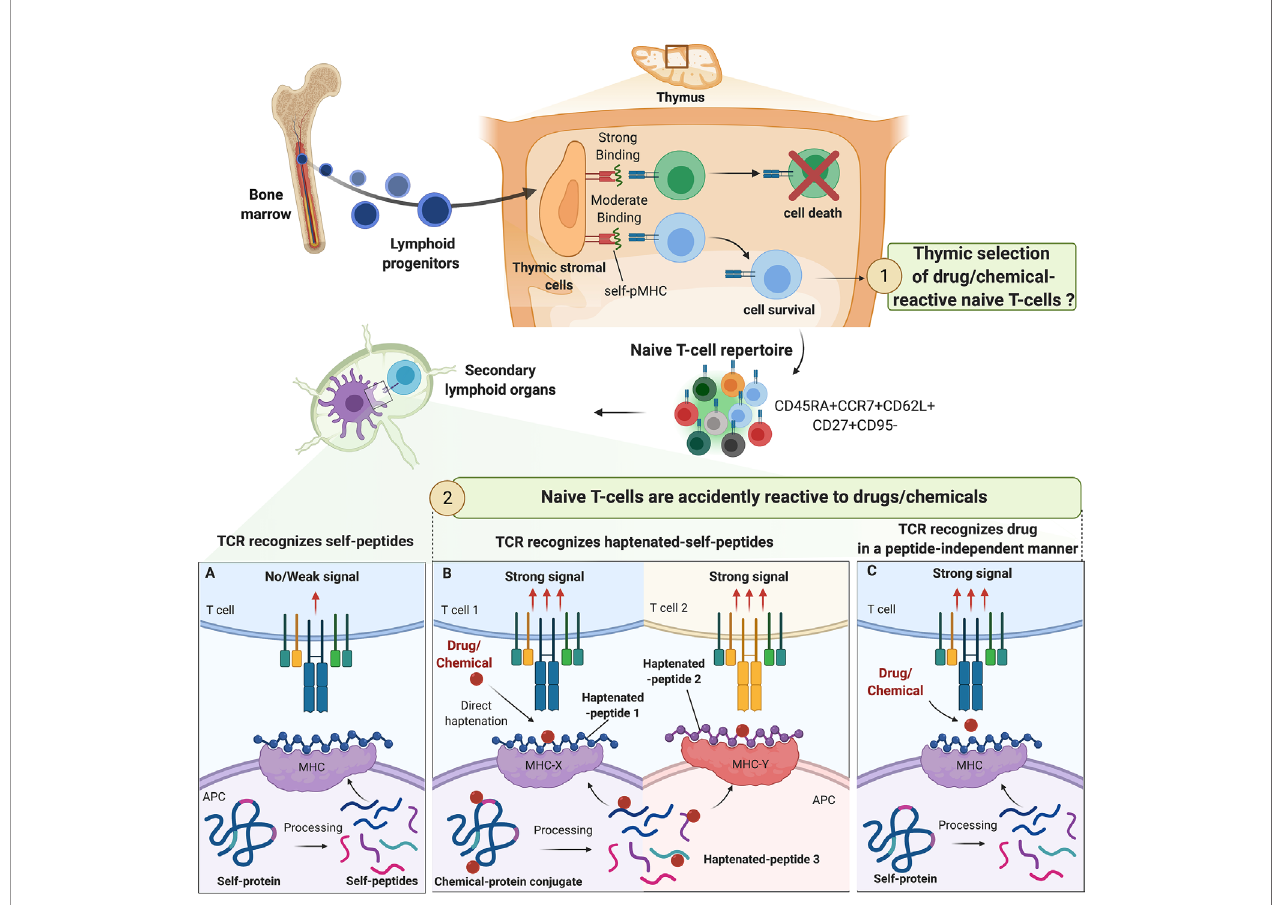
FIGURE 1 | Origin of drug/chemical-reactive naive T-cell repertoire. The fate of naive T-cell precursors is dependent on the recognition of self-peptides (self- p) presented by MHC molecules on thymic stromal cells. In the periphery, naive T cells expressing CD45RA, CD62L and CCR7 constantly circulate between secondary lymphoid organs and blood in pursuit of their speci fi c antigens. The origin of drug/chemical responsive T cells is unclear but thymic selection of drug/chemical-speci fi c naive T cells is unlikely. The process of central selection ensures that TCRs do not bind strongly to any self-pMHC molecules in the periphery, preventing autoimmune reactions (A) . Drugs/chemicals may alter self-pMHC complex and haptenated self-pMHC could have a high af fi nity for their corresponding TCR. Depending on chemical reactivity, multiple haptenated peptides can be generated from one self-protein allowing a diversity of association with different alleles and contributing to the high prevalence of immunization/allergy observed with some drug/chemicals (beta-lactams, skin sensitizers) (B) . In some cases, drugs/chemicals bind to MHC proteins in a peptide-independent manner to directly activate naive T cells mimicking the conditions of alloreactivity (C)